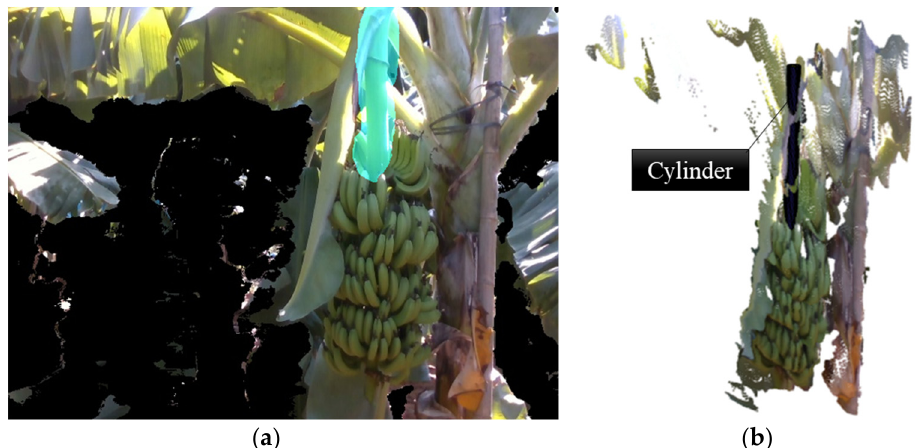
Figure 8. Example depicting the image processing pipeline. ( a ) Banana stalk segmentation; ( b ) cylinder fitting.